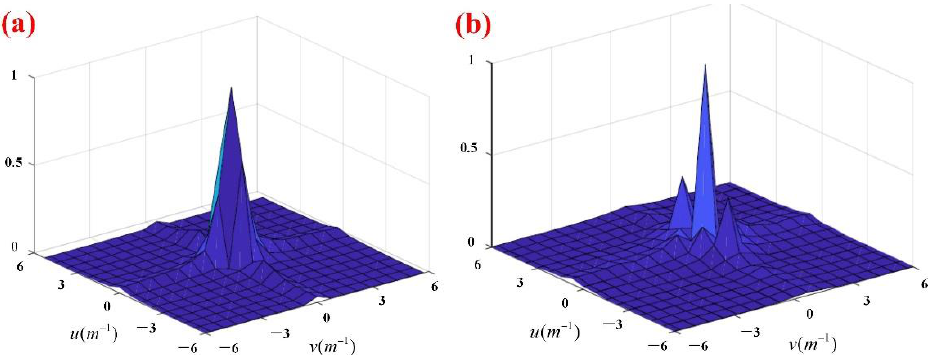
Figure 16. ( a ) Terrain amplitude spectral distribution in November 2020; ( b ) Terrain amplitude spectral distribution in May 2021 (local enlarged, normalization and centralization).